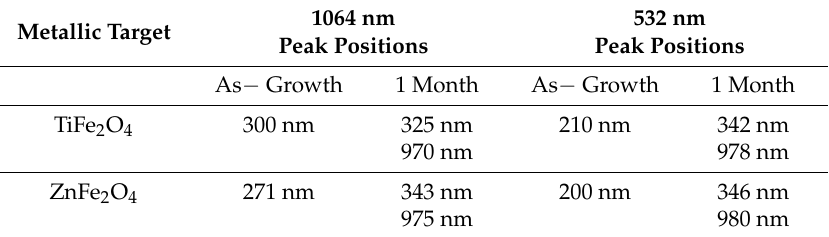
Table 1. Principal absorbance peak of MONPs.